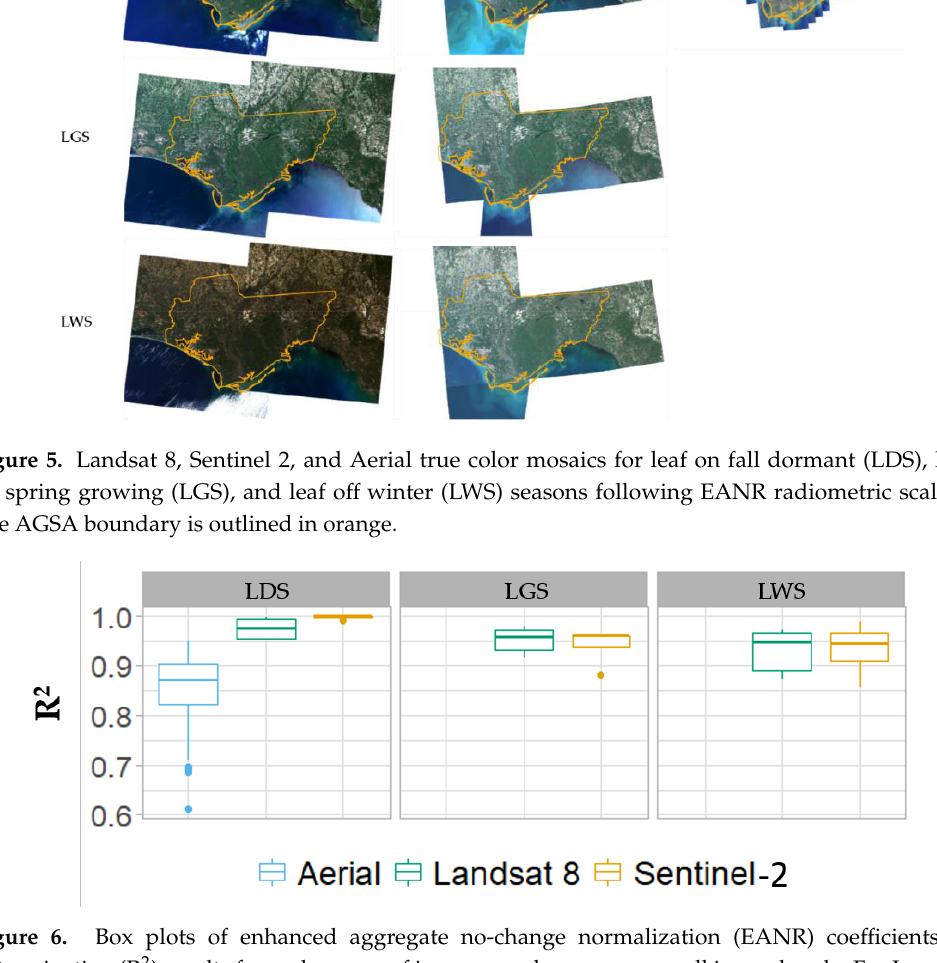
Figure 6. Box plots of enhanced aggregate no-change normalization (EANR) coefficients of determination (R 2 ) results for each source of imagery and season across all image bands. For Landsat 8 and Sentinel 2, the reference and subject images were of the same source; for Aerial analyses, the reference images were normalized Landsat 8 imagery.